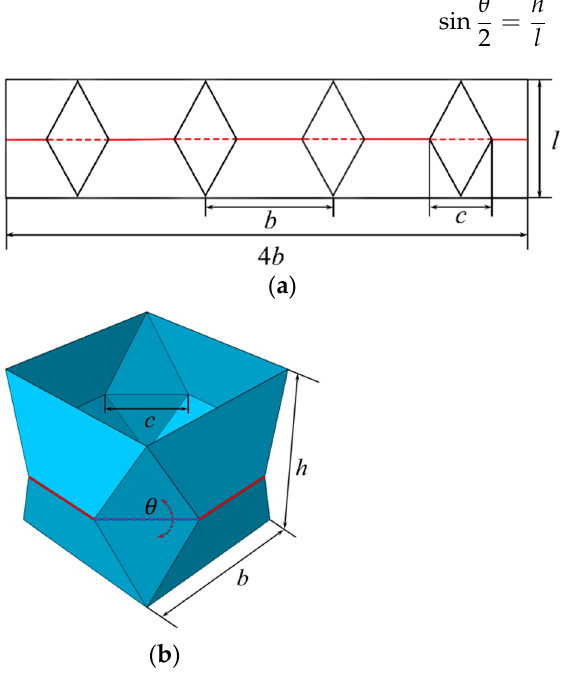
Figure 2. ( a ) The origami pattern of a module for OCB; ( b ) a module of